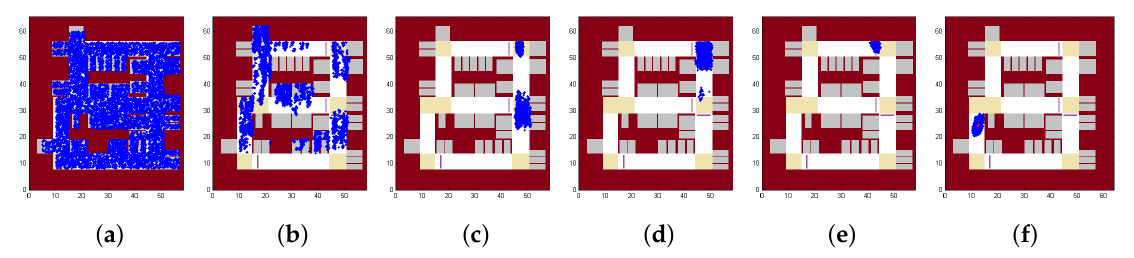
Figure 8. Particles over time.